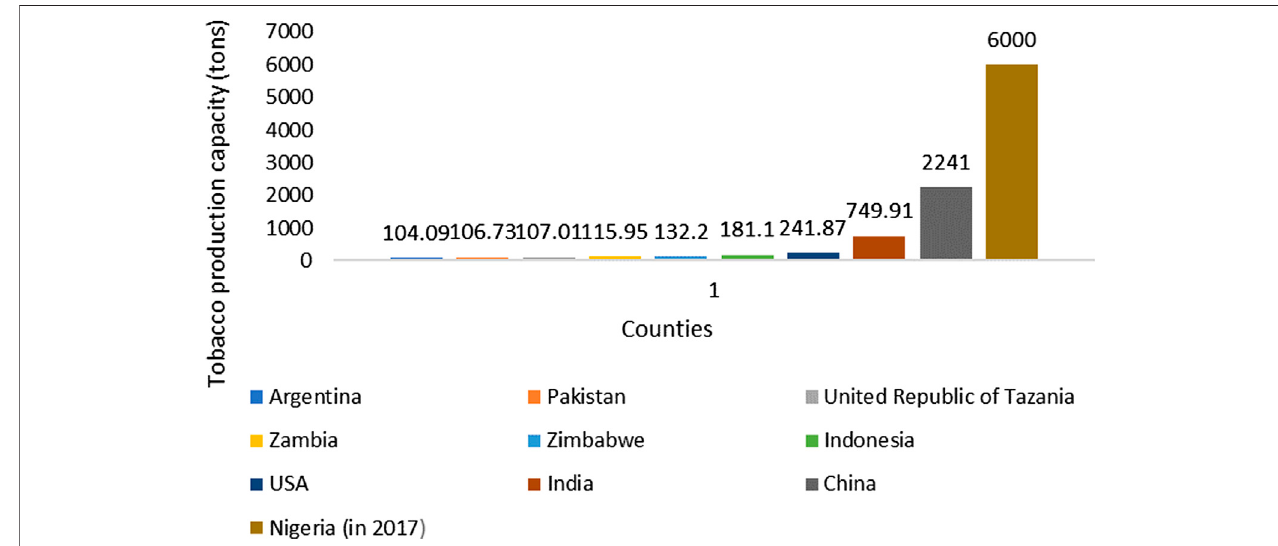
FIGURE 1 | Tobacco production capacity for ten countries.